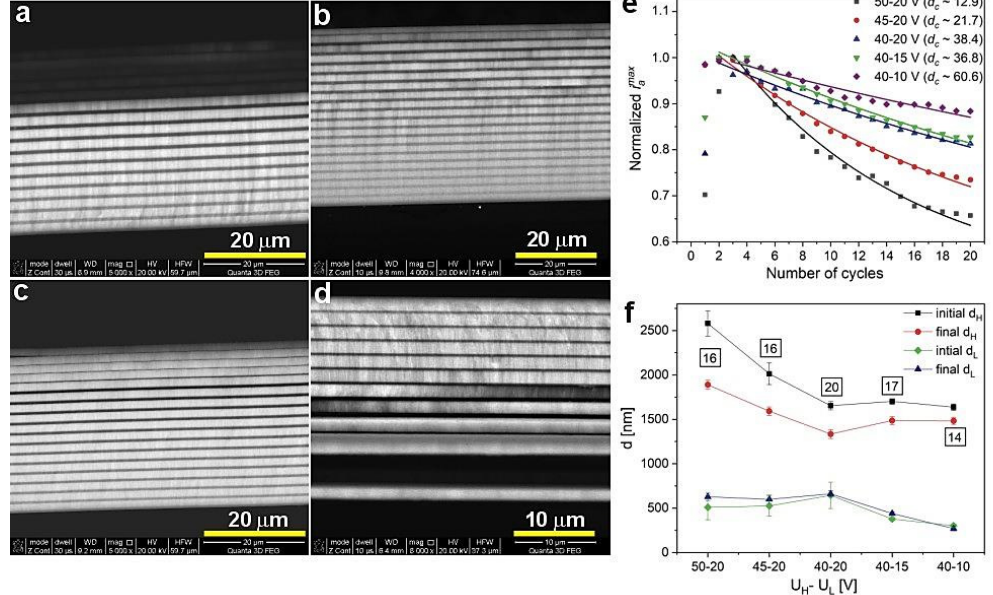
Figure 6. BSE images of the samples PAA_45-20 ( a ), PAA_40-20 ( b ), PAA_40-15 ( c ), PAA_40-10 ( d ), normalized i amax (the data for the PAA_50-20 sample comes from ref. [27]) as a function of number of cycles ( e ) and initial and final d H and d L layer thickness for the presented samples ( f ); in black squares—the number of d H + d L pairs.